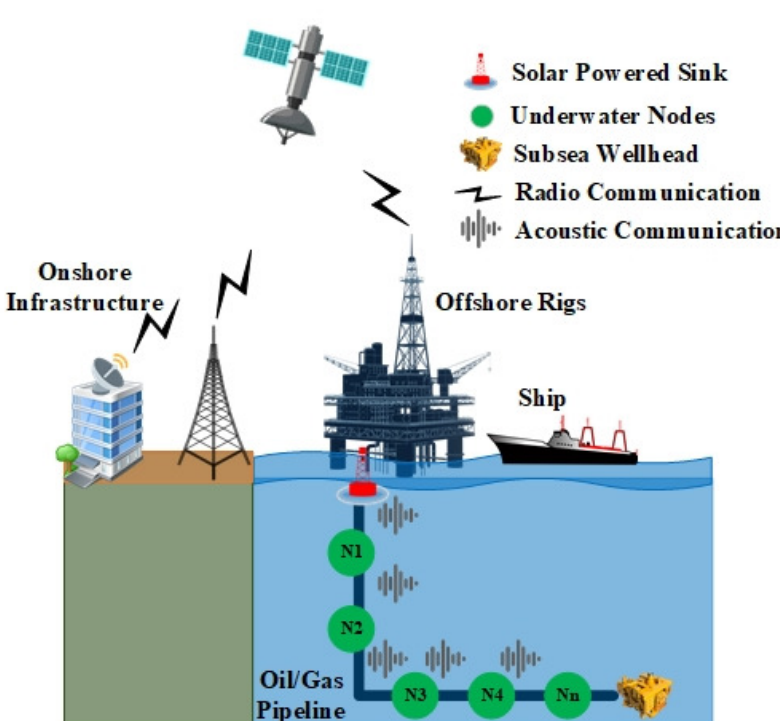
Figure 4. Simulation Network Topology [34] @ 2021